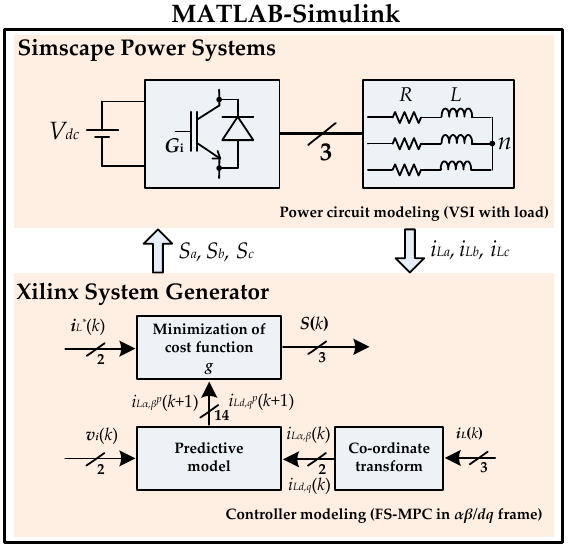
Figure 5. Block diagram representation for modeling and simulation.